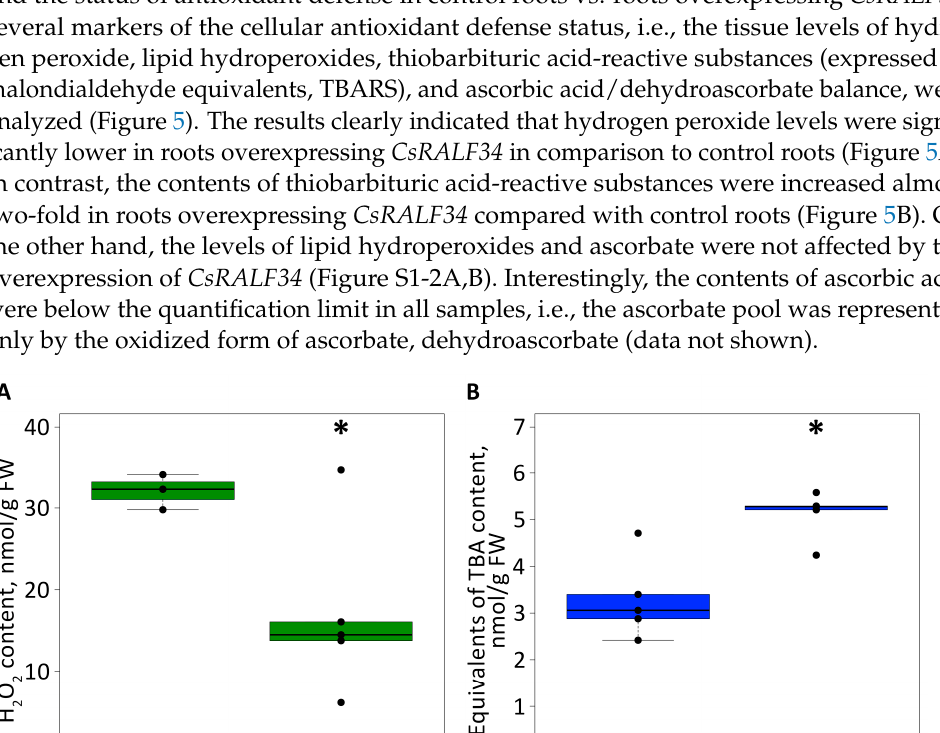
Figure 4. Relative transcript levels of Cucumis sativus RALF34 , GATA14 , GATA24 , and E2F/DP genes in control roots and in roots overexpressing CsRALF34 . GUS control, transgenic roots expressing GUS ; RALF34-OE, transgenic roots overexpressing CsRALF34 . Statistical analysis using Wilcoxon’s signed-rank test showed signi fi cant di ff erences (*, p < 0.05) between expression levels in the overex- pression group compared with the control only for CsRALF34 (asterisk). The y -axis indicates relative transcript levels (2 −ΔΔ CT method).